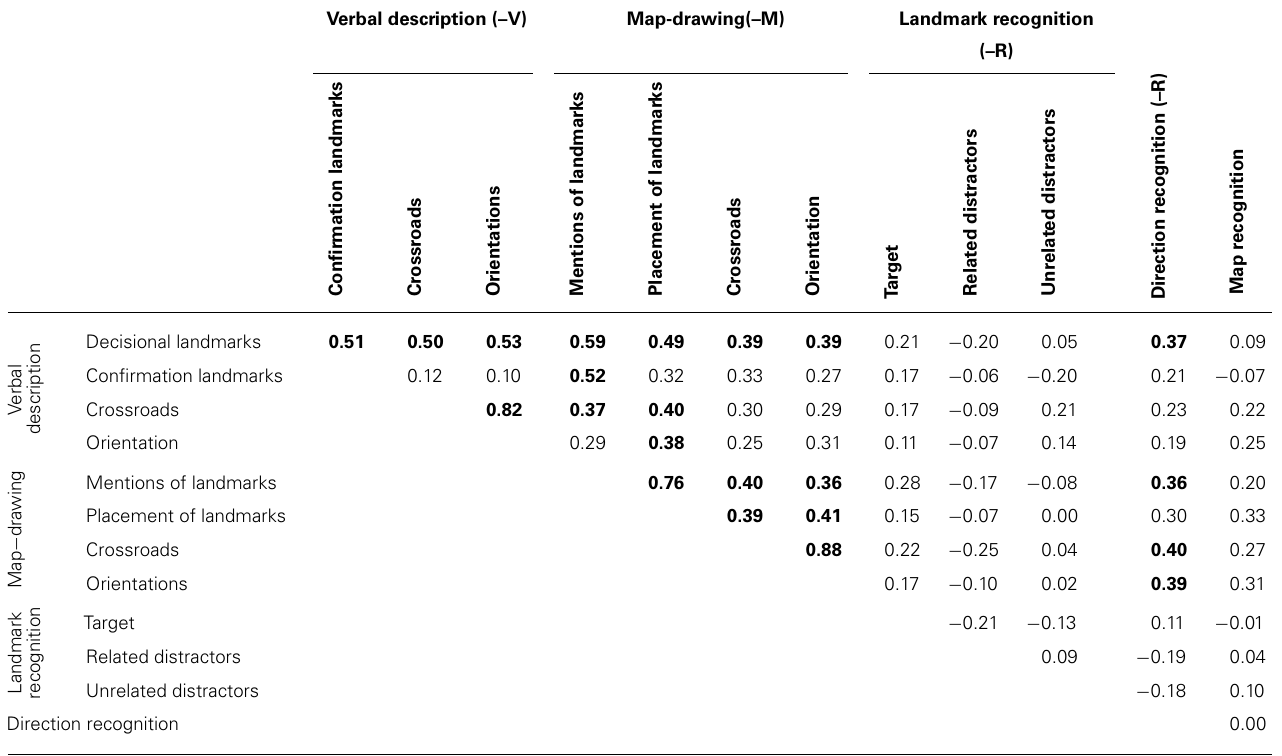
Table 2 | Partial correlations (controlled for age) among the different route measures (significant value in bold if up to p < 0.05; with Bonferroni correction). Verbal description (–V)